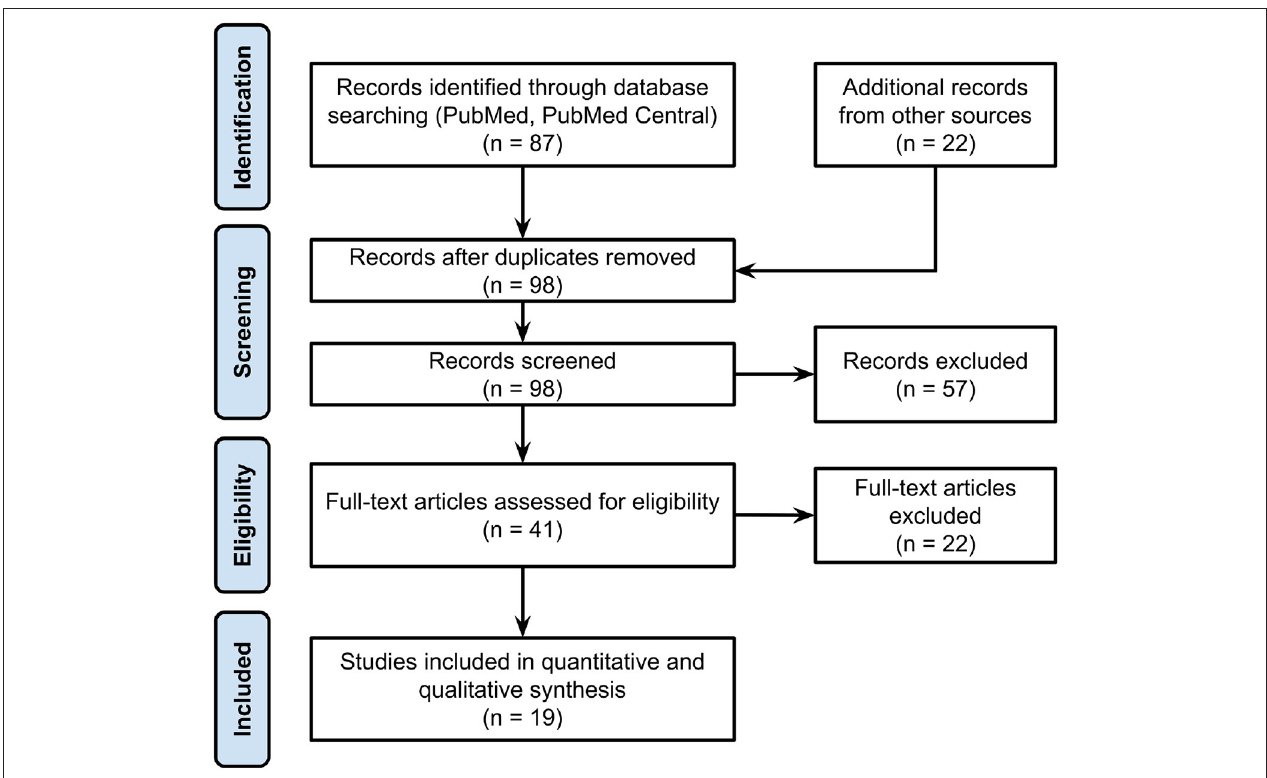
FIGURE 1 | PRISMA flow chart of the method used for articles’